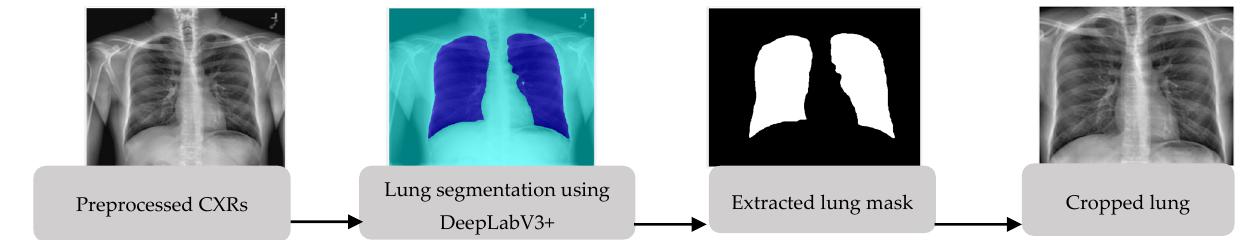
Figure 5. Segmentation of lung regions using DeepLabV3+ and cropping .